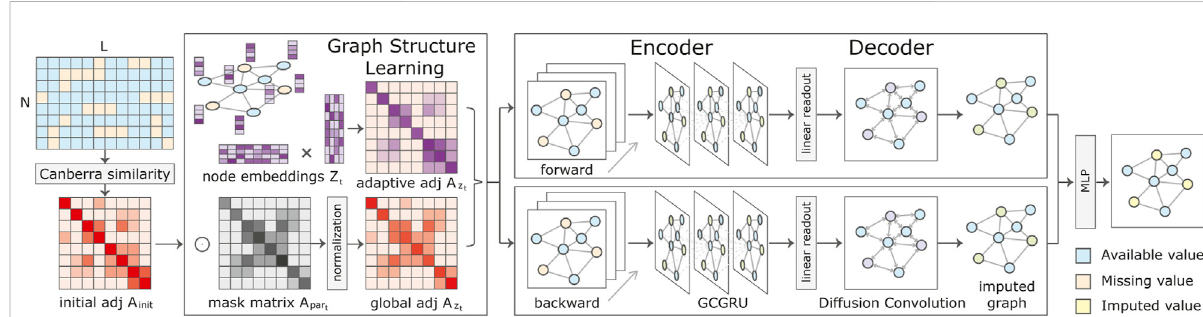
FIGURE 1 Model architecture of the proposed Adaptive Graph Convolutional Imputation Network (AGCIN). The initial adjacency matrix is obtained by computing the pair-wise Canberra similarity of the sensor sequences. The graph structure learning module re fi nes the learned graph topology by combining global and adaptive adjacency matrices. Each of the forward and backward imputation modules is composed of an encoder and a decoder. The encoder sequentially processes the input sequences with missing values to obtain the hidden node representations. In the decoder, the fi rst-stage imputation is performed through a linear readout function, and the spatial decoder re fi nes imputed values in the second stage. The fi nal imputations are obtained through an MLP aggregating the forward and backward learned node